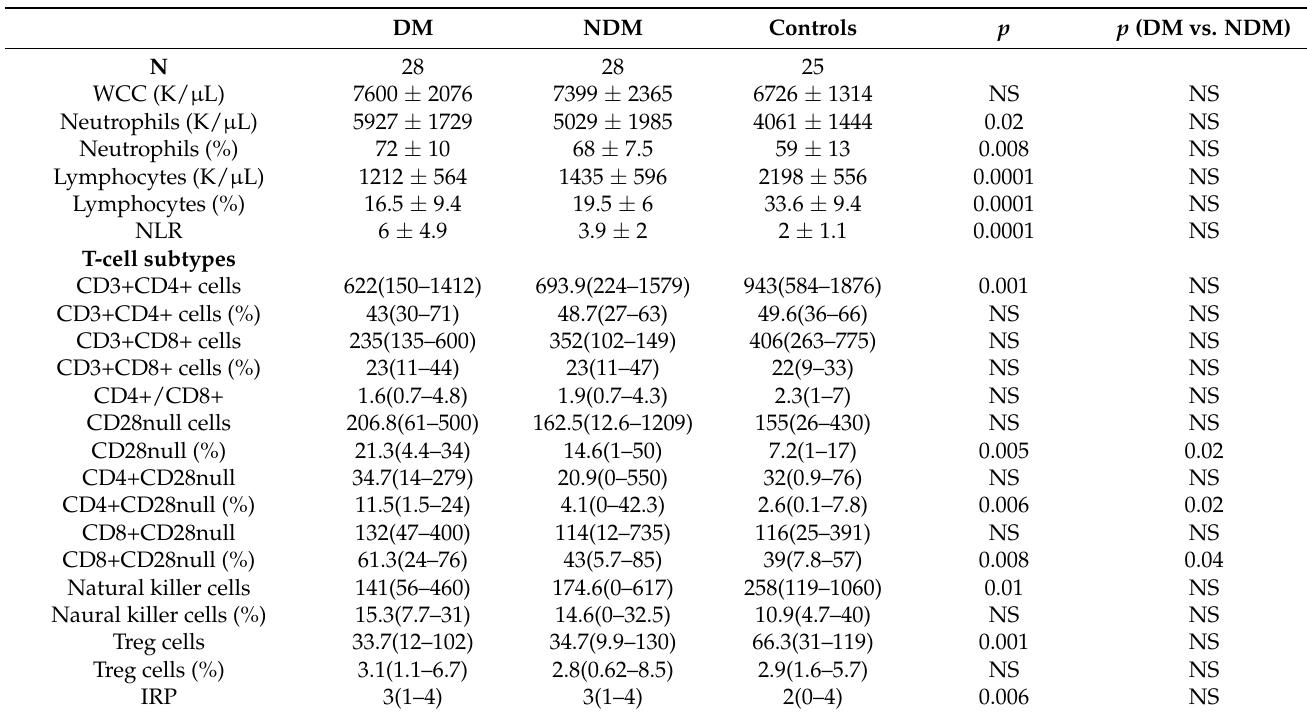
Table 2. Lymphocytes and T-cell subsets in patients (DM, NDM) and controls; p value calculated for differences between three groups (ANOVA or Kruskal–Wallis H test), and between DM and NDM (Mann–Whitney U test). WCC, white-cell count; NLR, neutrophil/lymphocyte count; IRP, immunological risk profile.